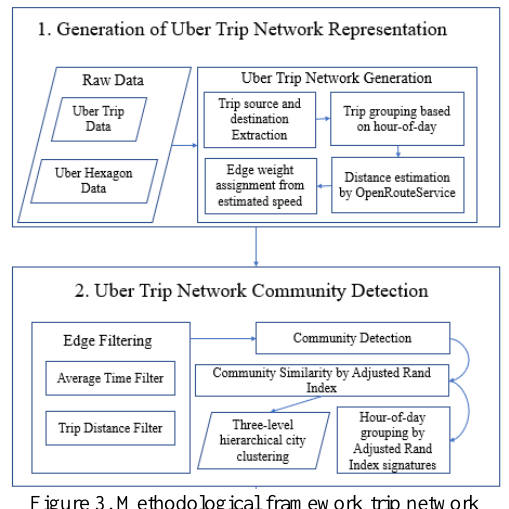
Figure 3. Methodological framework trip network representation and community